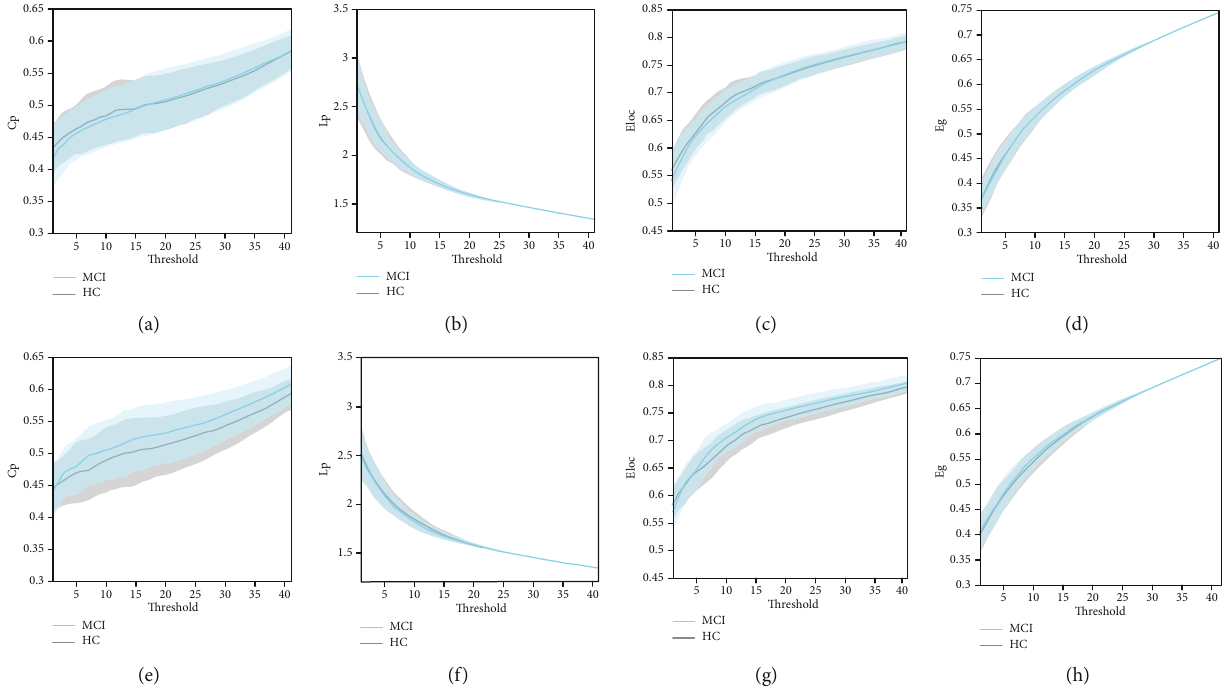
Figure 3: Small-world network parameters of the HCs (grey line) and MCI patients (blue line) using Pearson correlation (a-d) and sparse L1- norm regularization (e-f). Shaded areas indicate the standard